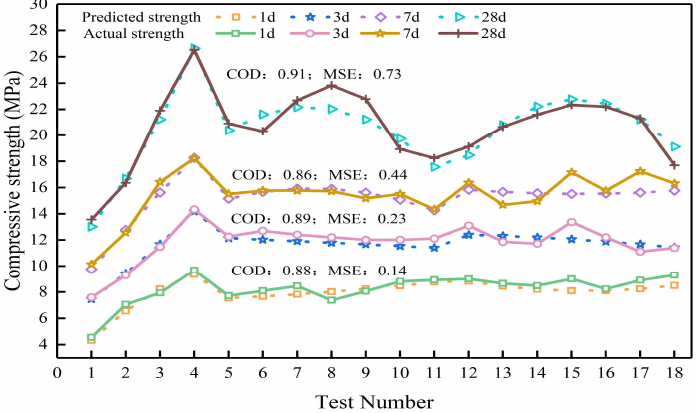
Figure 26. Variation curves of predicted and measured value of models with different age.